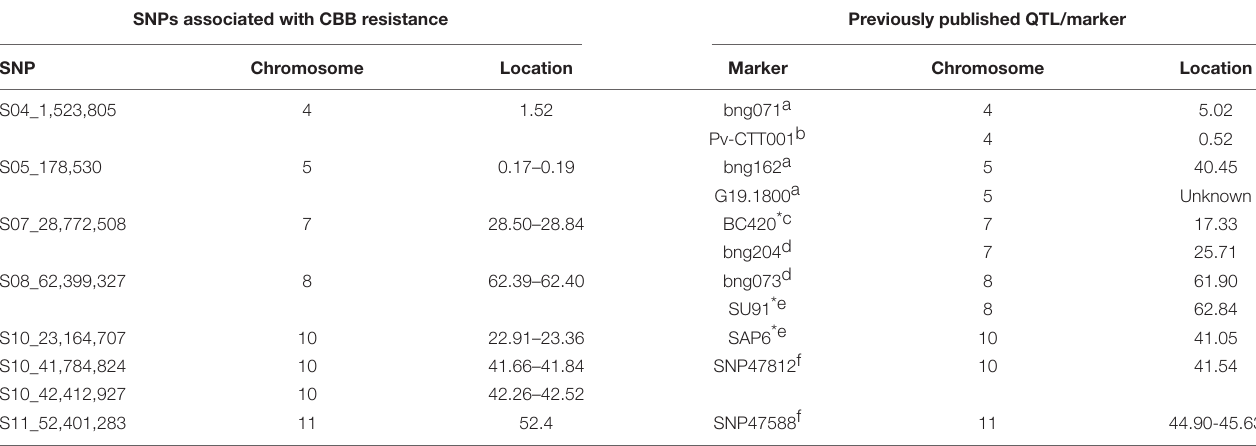
TABLE 6 | Comparison of the physical locations of markers previously associated with common bacterial blight (CBB) resistance similar to the locations identified in the NDSU breeding